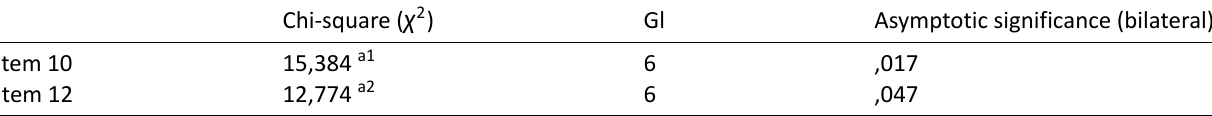
Table 4. Chi‐square (item 10 and item 12).